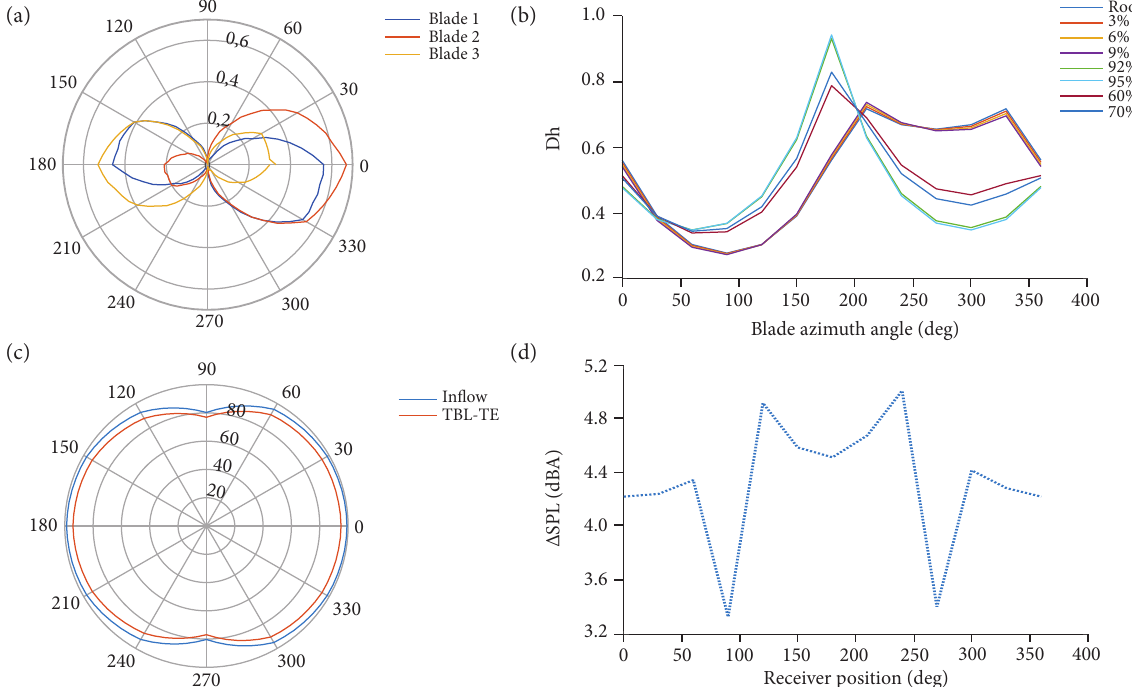
Figure 2. (a) Polar plot of high frequency blade directivity of the 3 MW wind turbine during one revolution; (b) directivity change for single blade at different span locations with respect to blade azimuth (source height – 80m); (c) polar plot of sound power levels from turbulent infl ow and turbulent boundary layer trailing edge noise sources at wind speed of 8 m/s for different receiver positions (0° to 360°); (d) computed change, ∆ dBA, between TBL-TE and infl ow noise at wind speed of 8 m/s.